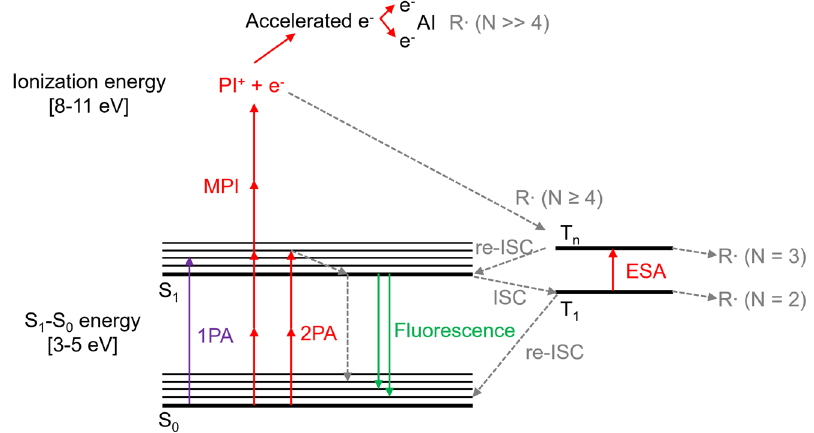
Figure2: Jablonskidiagram.2PAandMPIare